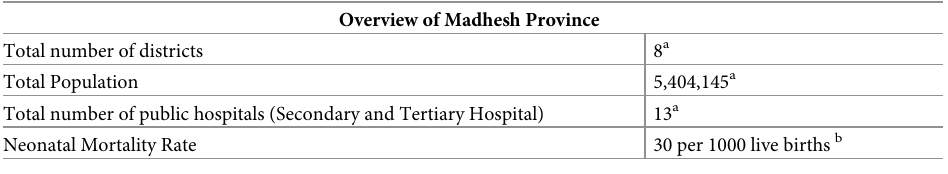
Table 1. Overview of Madhesh